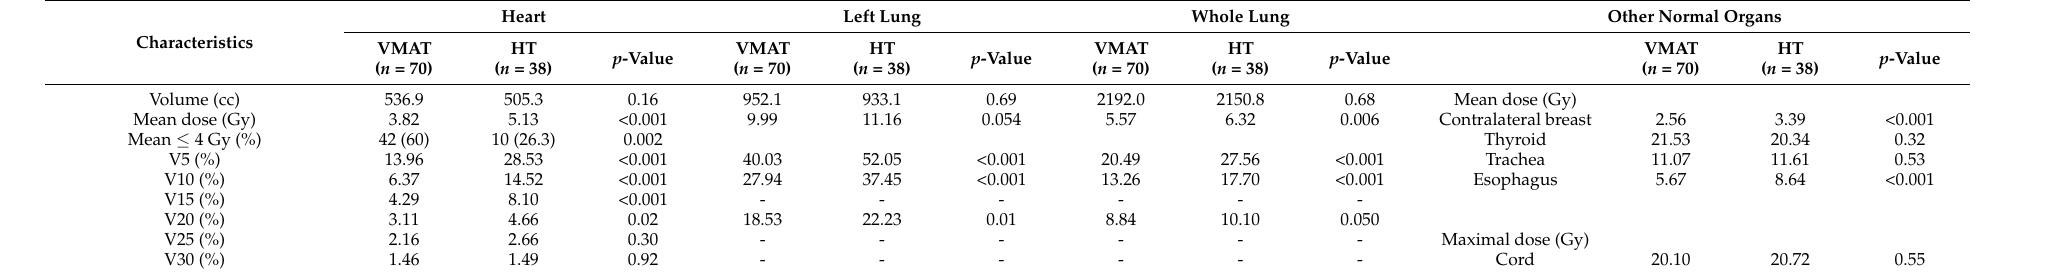
Table 2. Comparison of RT treatment factors and dosimetry parameters between VMAT and HT in all eligible patients.